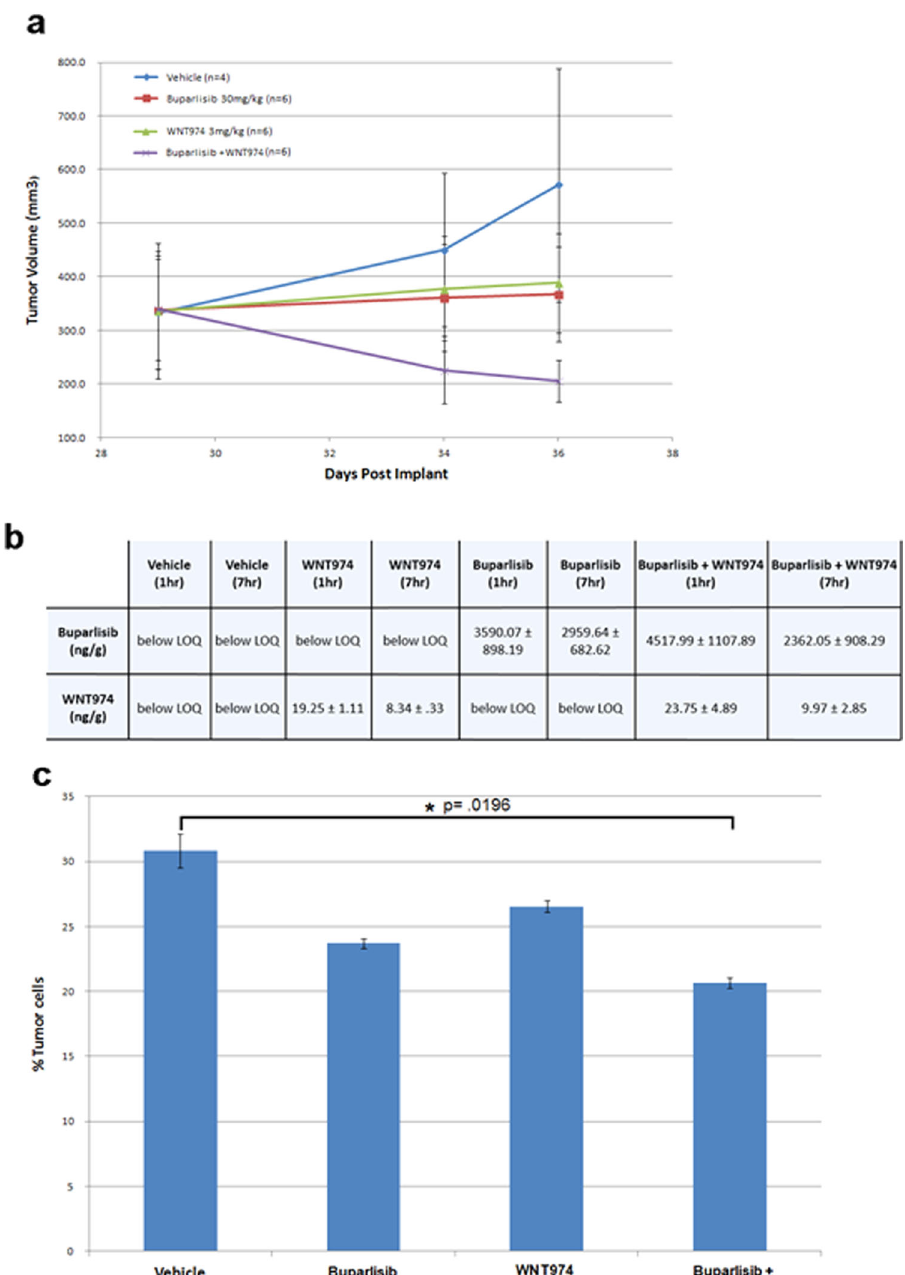
Fig. 4 Pharmacodynamic study of buparlisib + WNT974 using cell line xenografts of the TNBC cell line, TMD231 (a MDA-MB-231 cell line variant that metastasizes to the lung). a Graph of tumor volumes of NSG mice implanted with TMD-231 cells and treated with vehicle, buparlisib, WNT974, or the combination. After 7 days of treatment, we observe a ~40% decrease in tumor volume. b Quanti fi cation of drug in tumors resected from mice treated in our PD study. Half of the tumors were resected at 1 h post the last dose, and the other half 7 h post the last dose. Using Highperformance liquid chromatography-mass spectrometry (HPLC-MS/MS), buparlisib and WNT974 were quanti fi ed as nanograms of drug per gram of tumor tissue (ng/g). Average values with standard deviation are presented. LOQ limit of quantitation c As TMD-231 cells